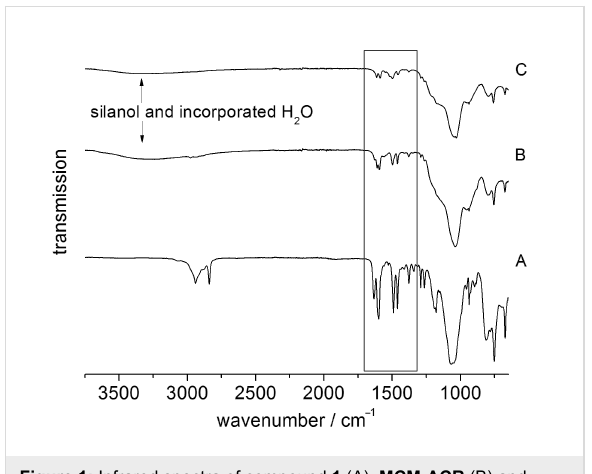
Figure 1: Infrared spectra of compound 1 (A), MCM-ACR (B) and MCM-ACR + Sc(OTf) 3 (C). The box marks the section given in Figure 2 (resolution ±2 cm − 1 ).